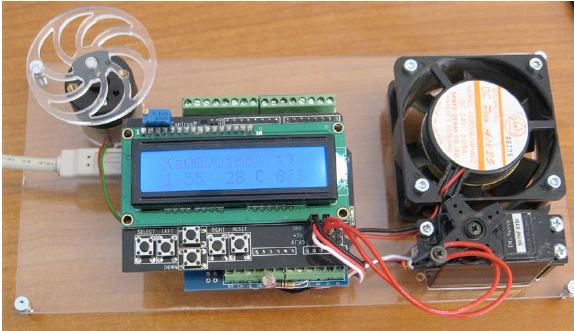
Figure 4. Arduino kit test bench in